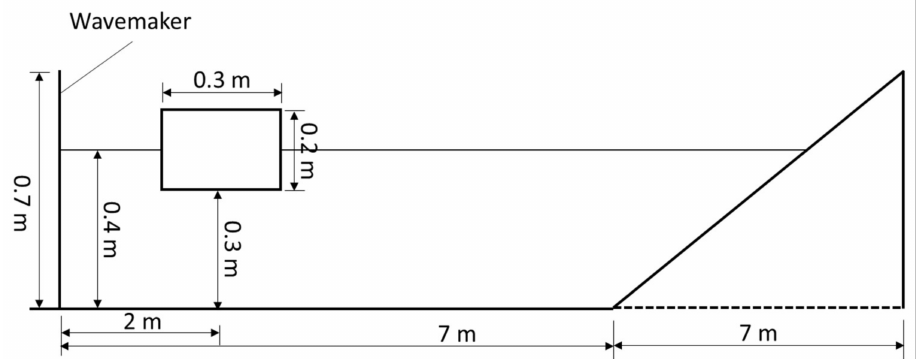
Figure 4. Wave tank used to simulate the fluid–floating-box interaction.